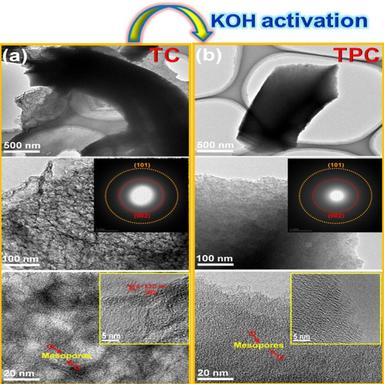
HR-TEM images of (a) TC and (b) TPC samples at different magnifications.